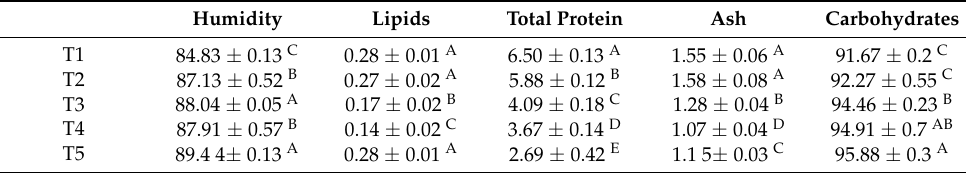
Table 2. Bromatological analysis of the fruiting bodies of P. djamor in 5 different treatments. Humidity Lipids Total Protein